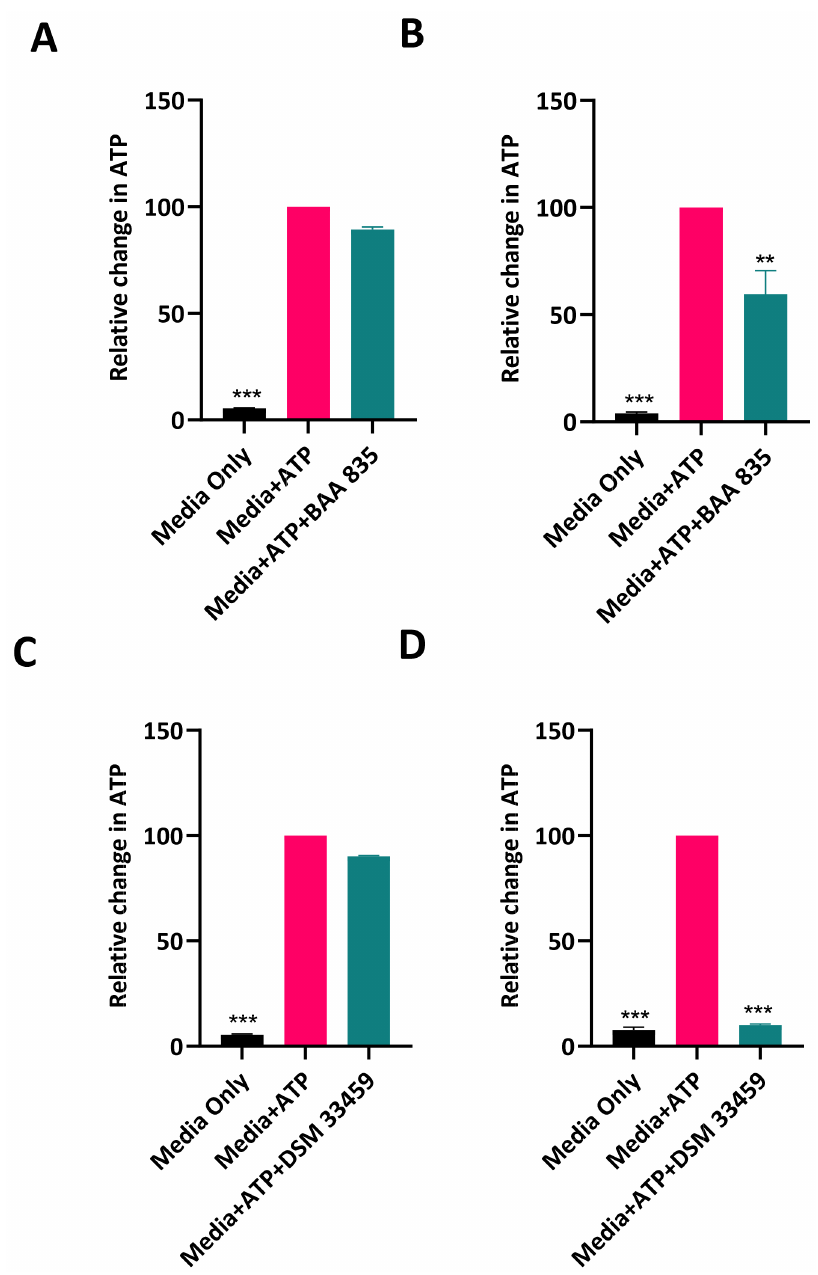
Figure 5. ATP amounts were detected in the supernatants for A. muciniphila ATCC BAA-835 at time 0 ( A ) and after 8 h of growth ( B ). ATP was estimated in the supernatants from Akkermansia sp. DSM 33459 at time 0 ( C ) and after 8 h of growth ( D ). Each experiment was conducted with duplicate wells and was repeated at least three times. Data are presented as mean ± SEM. One-way, two tailed ANOVA followed by Dunnett’s multiple comparisons test were used for statistical